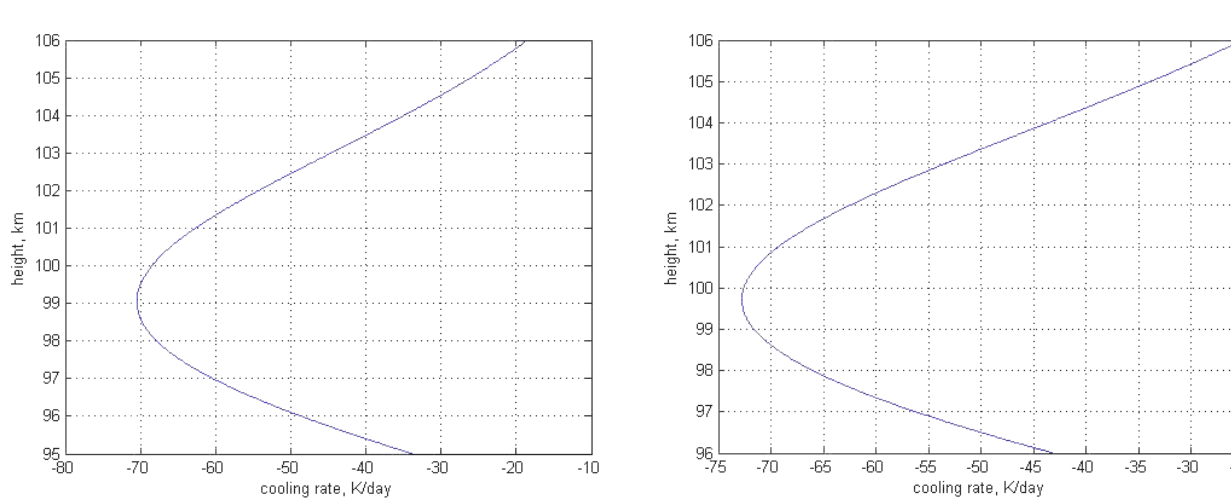
Fig. 6c. Height profile of the cooling rate calculated with K eh = K ed inferred from the [He] distribution at the summer equator